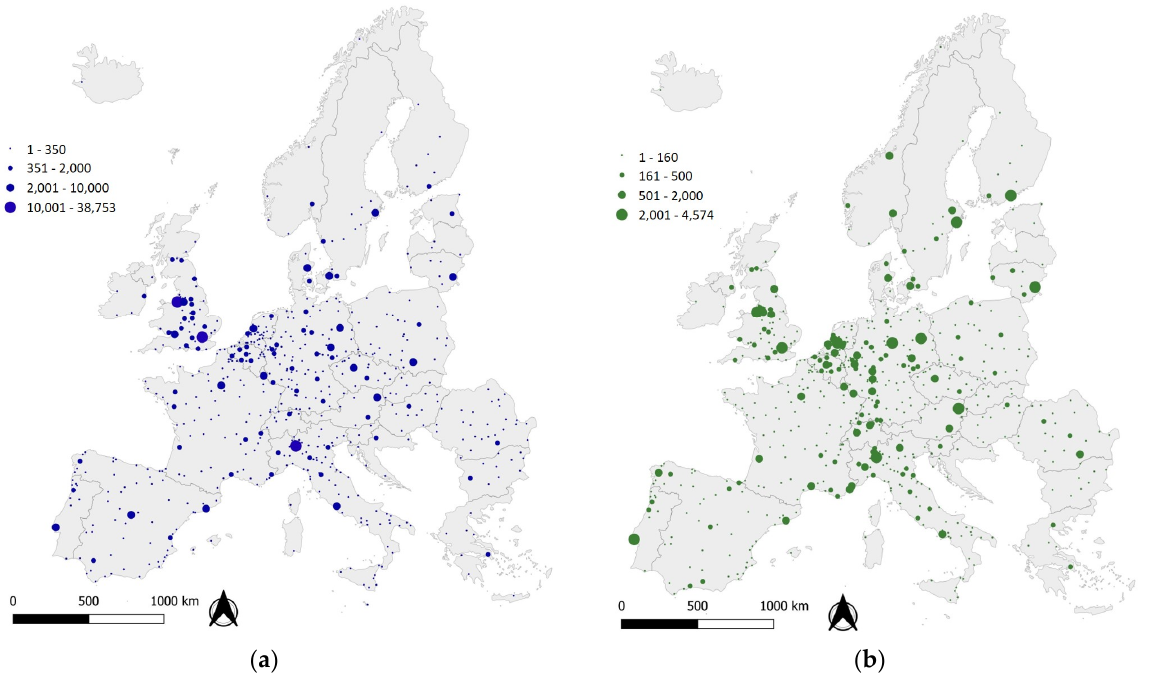
Figure 1. Total number of observations in green areas ( a ) and forests ( b ) within cities. Cities without observations are not shown in the map.